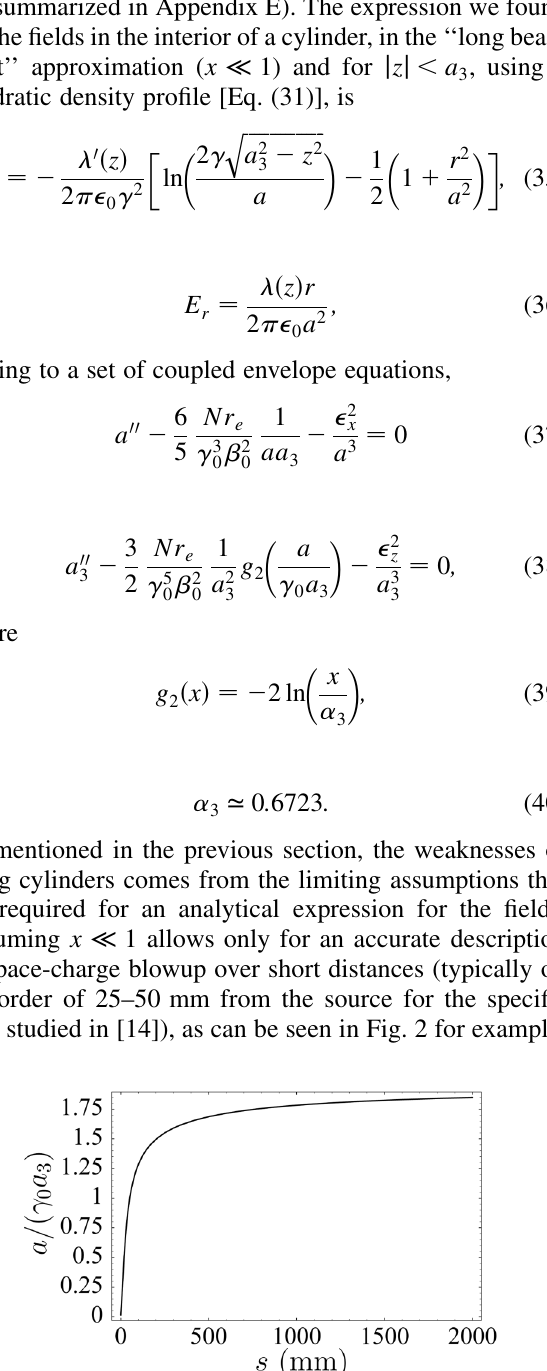
FIG. 1. Ratio of longitudinal forces g and transverse forces 1 (cid:6) x 2 g function of the aspect ratio x (cid:1) a= (cid:2) (cid:7)